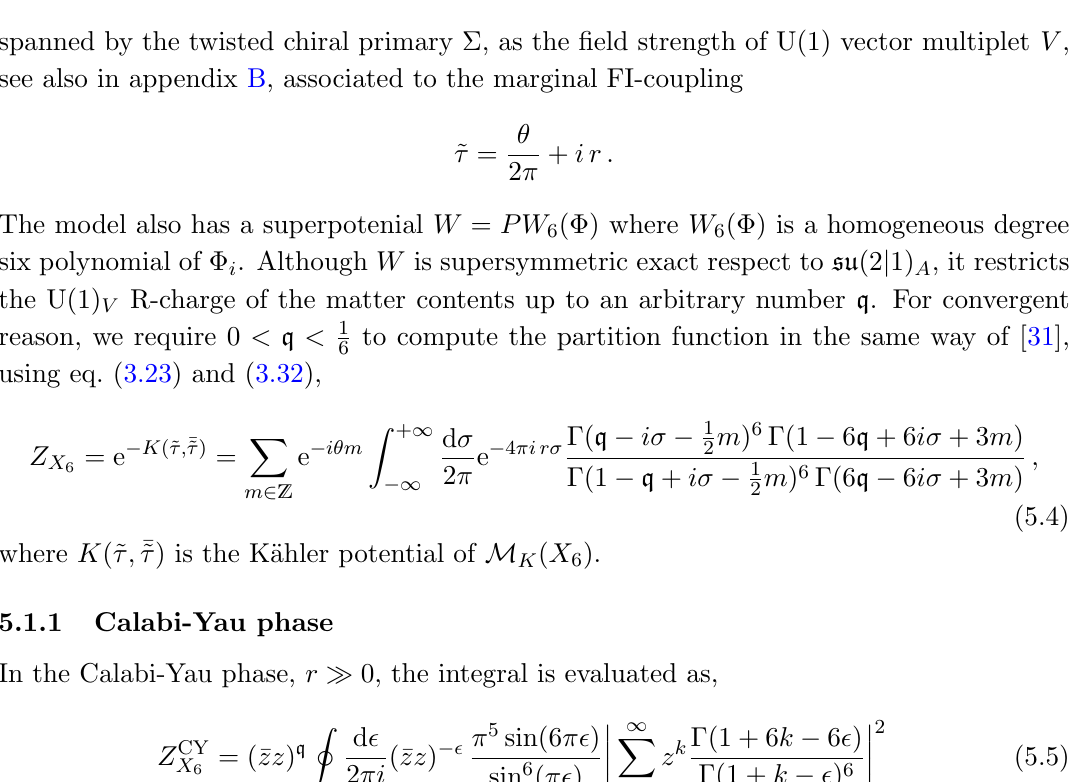
spanned by the twisted chiral primary (cid:6), as the (cid:12)eld strength of U(1) vector multiplet V